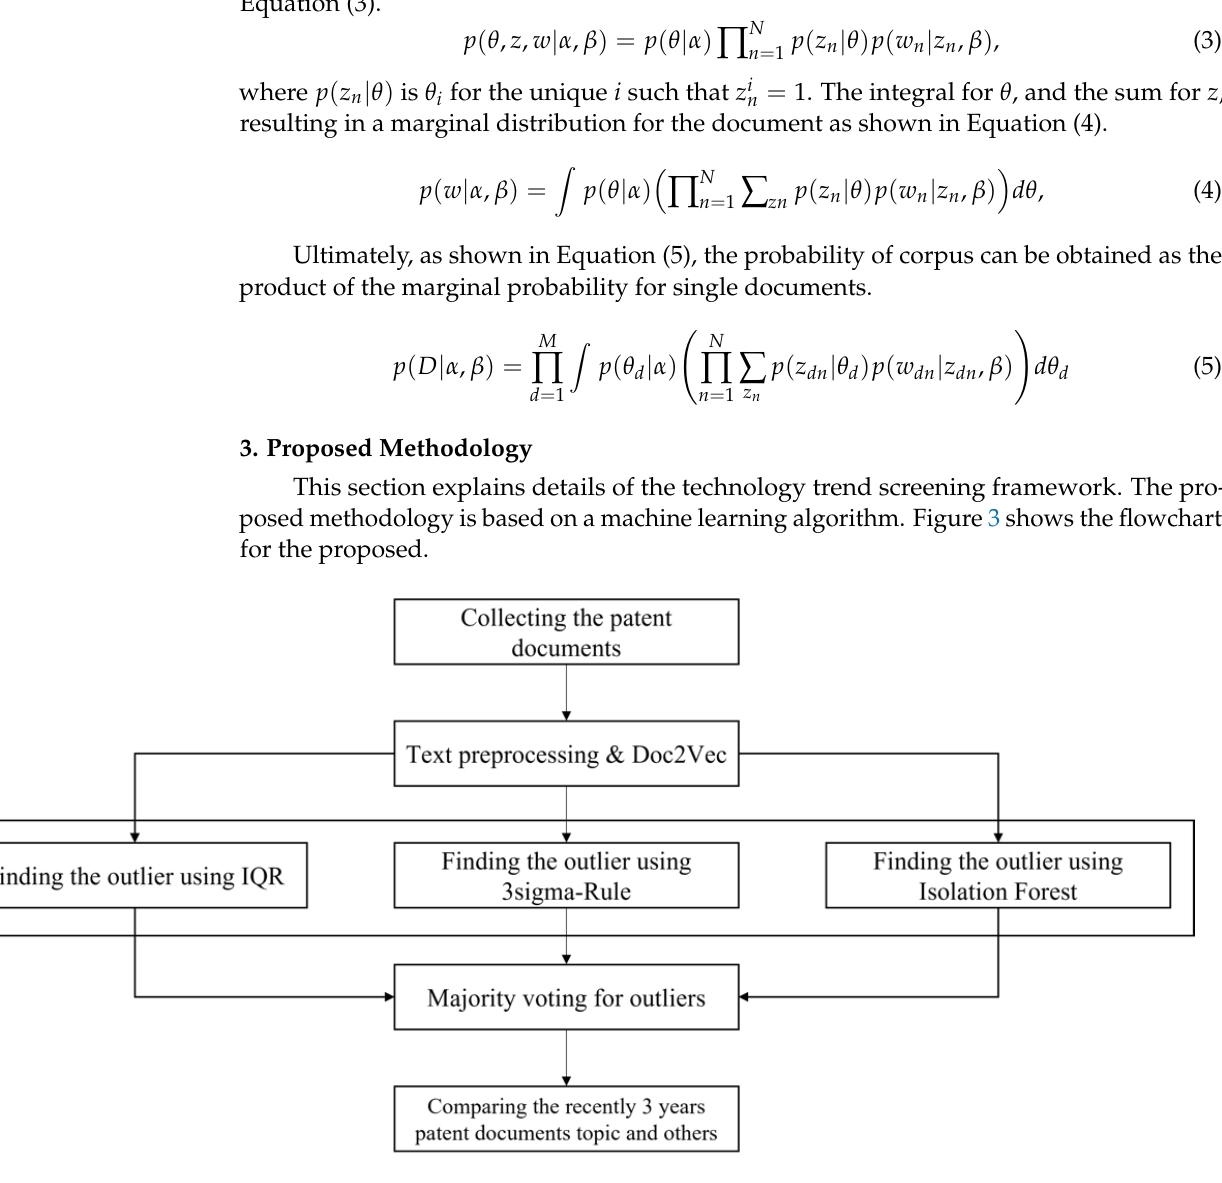
Figure 3. Flowchart for proposed technology trend screening.